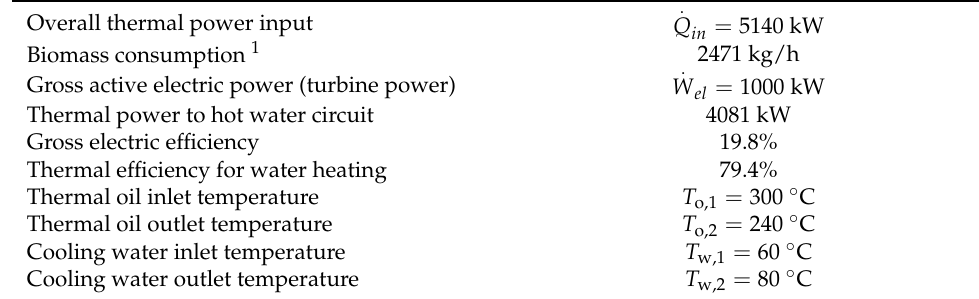
Table 1. Performance characteristics of the 1 MW el Turboden ORC 10 CHP commercial unit.